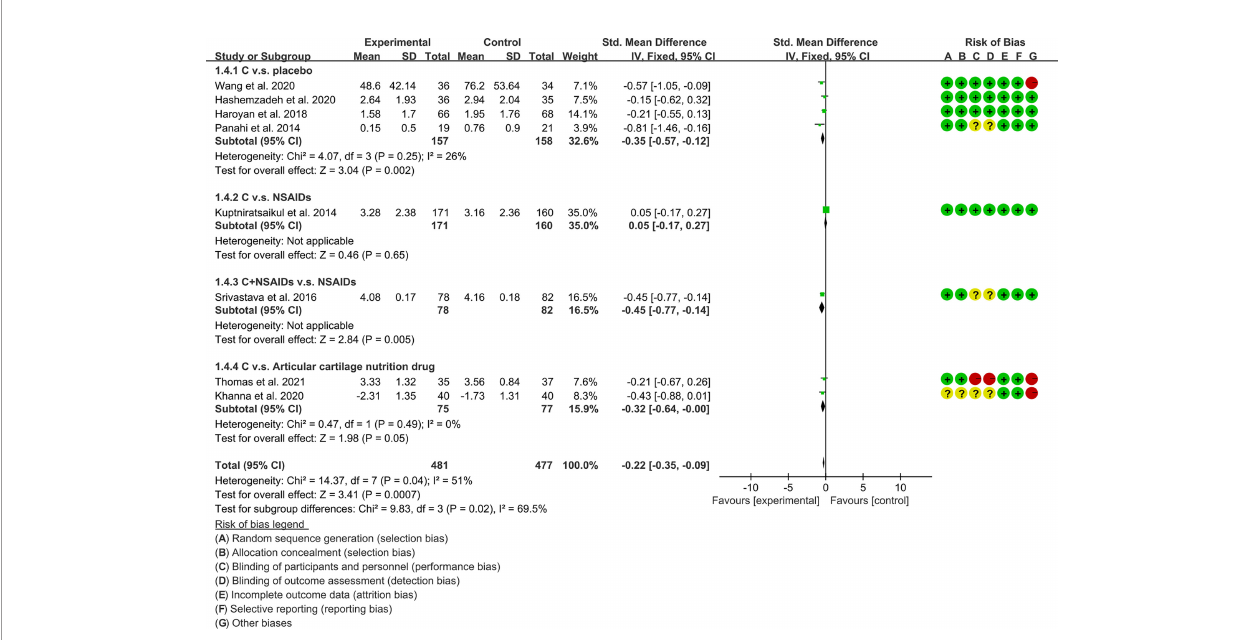
FIGURE 10 | WOMAC -stiffness.